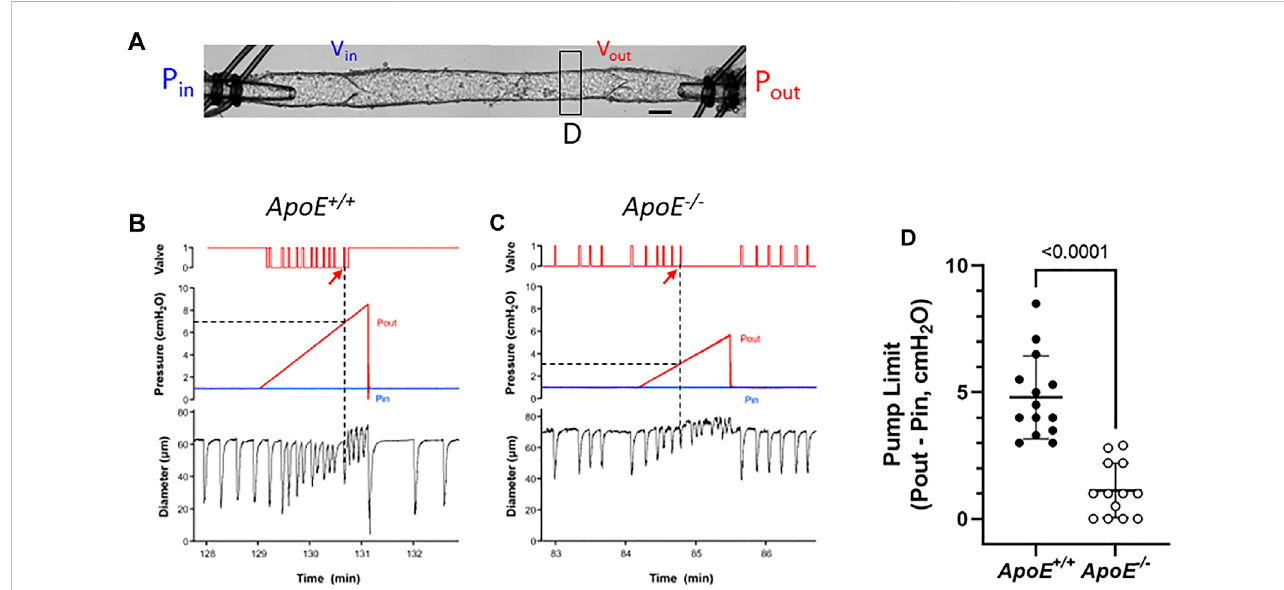
FIGURE 4 ApoE − / − vessels have impaired pump strength. (A) Experimental con fi guration used for pump test of a 2-valve lymphangion. Calibration bar = 35 μ m. Pump test examples for an ApoE +/+ vessel (B) and a ApoE − / − vessel (C) . (D) Pump test results for isolated, 2-valve popliteal lymphatic segments from ApoE +/+ and ApoE − / − mice. On average ApoE − / − vessels were only able to pump against an adverse pressure gradient of 1.2 cmH 2 O, compared to 4.8 cmH 2 O for ApoE +/+ vessels. Statistical differences were assessed via Mann-Whitney test. Valve positions: 1 = open; 0 = closed.